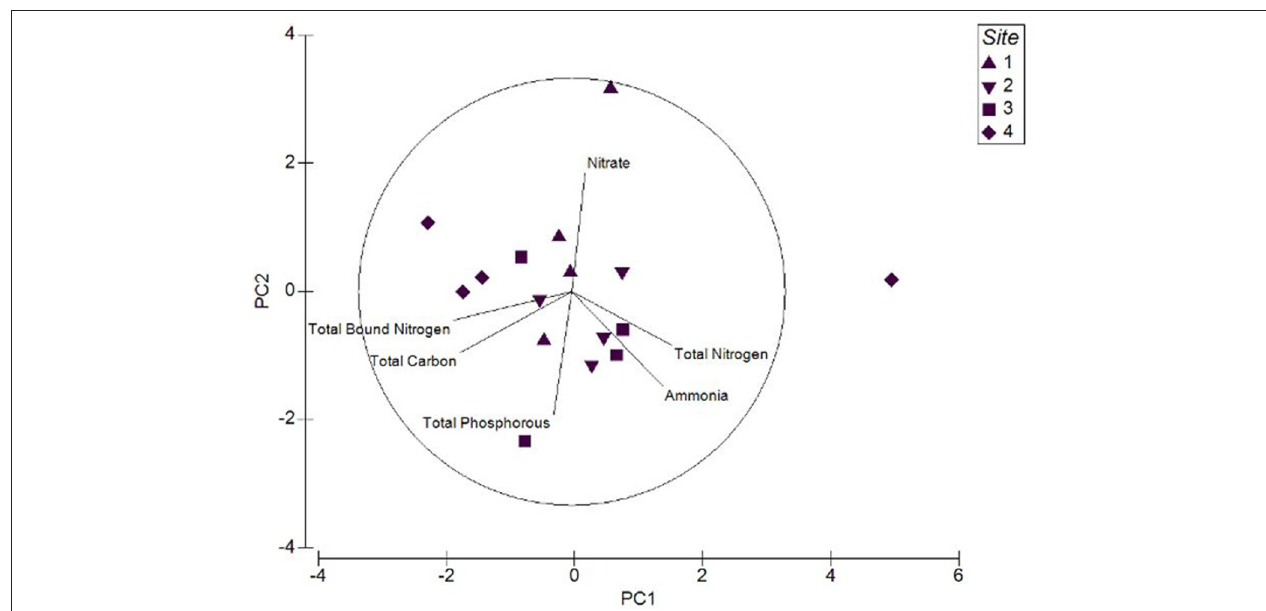
FIGURE 5 | Principal Component Analysis (PCA) plot for the sediment nutrient quality of the upstream and downstream sites.